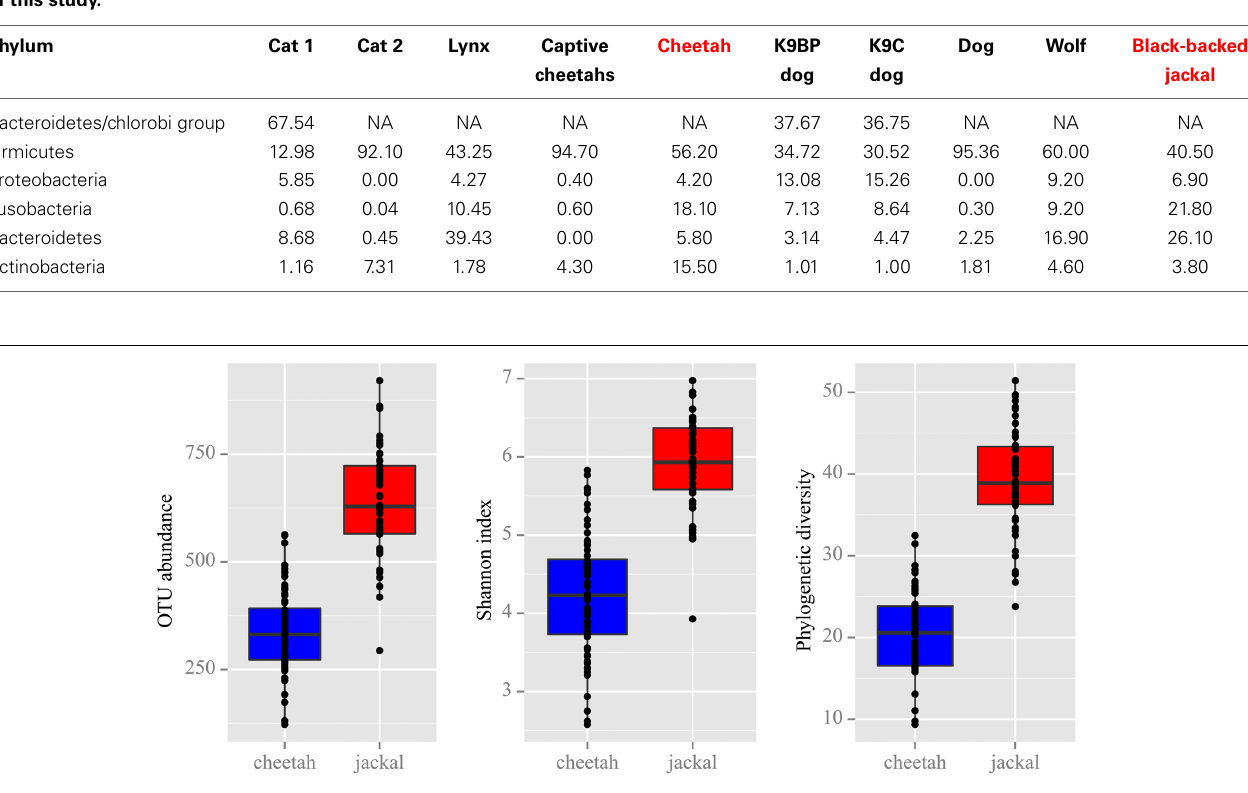
data of an individual black-backed jackal (left) or cheetah (right) based on a sub-sampling of 8000 reads per individual. The two species are similar in their phylum profiles and share all phyla with proportions above 0.2%.